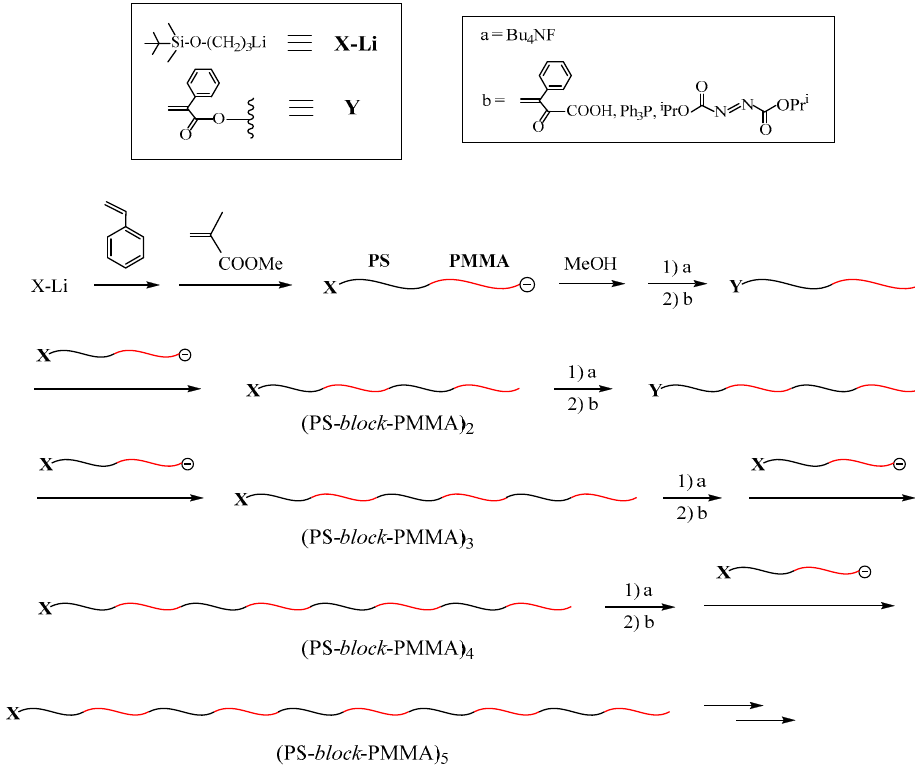
Table 11. Characterization results of (PS– block –PMMA) n , (PS– block –P t BMA) n and (PS– block –P2VP) n synthesized by the iterative